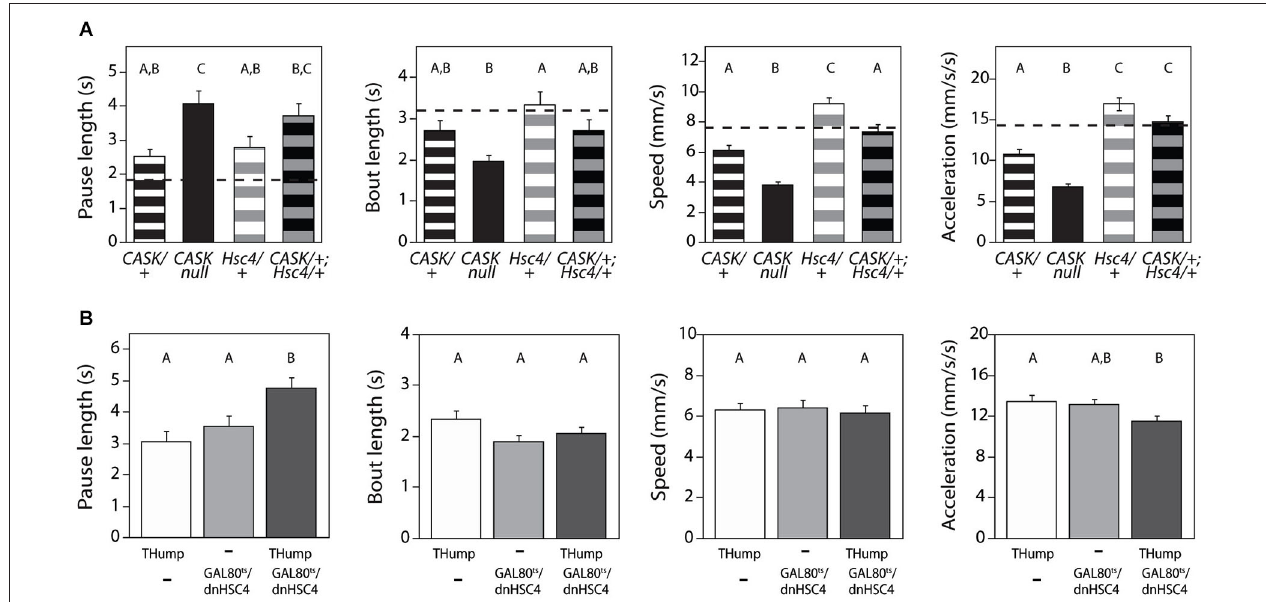
severity of phenotype. Genotypes of each group of animals are indicated below the histogram bars: “ CASK ” = CASK - β P18 , a null allele; “ Hsc4 ” = Hsc70-4 (cid:49) 19 , a hypomorphic allele; “ + ” = a WT allele. (B) A dominant negative Hsc70-4 transgene was expressed under control of THump-Gal4 and expression limited to adulthood using tub-Gal80 ts . Here “Thump” = THump-Gal4 and “Gal80 ts /dnHSC4” = tub-Gal80 ts /UAS-[dn]Hsc70-4 . Expression of this dominant negative construct in adult dopaminergic cells results in reduced motor initiation behavior (as evidenced by the change in the pause length parameter), but no significant changes in the other indices of locomotor behavior. As before, letters indicate significant differences between groups ( P < 0.05, ANOVA with Tukey HSD). See Section Methods for details on statistical